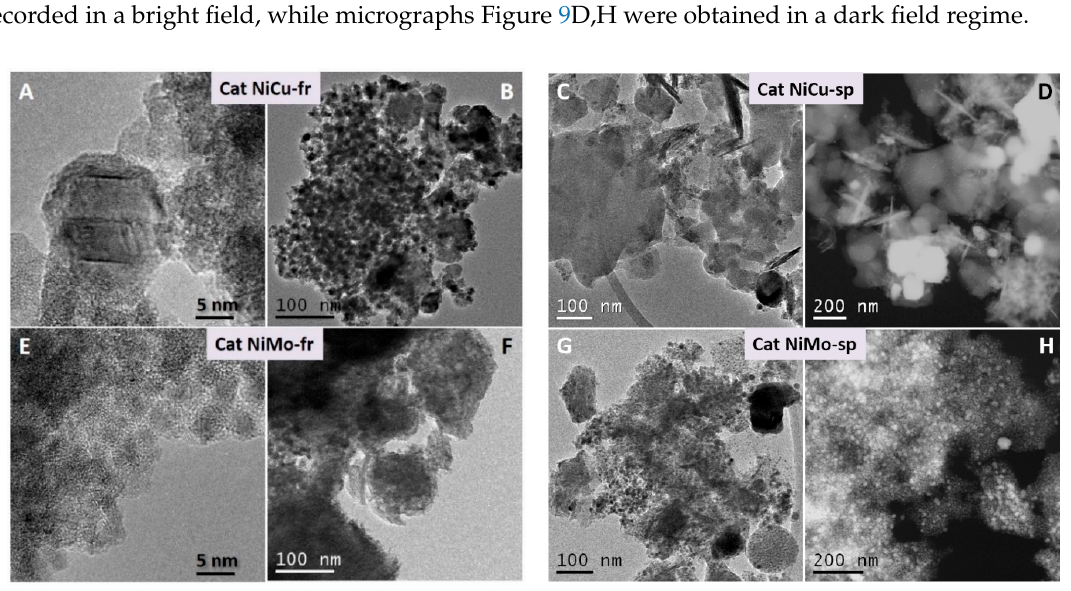
Figure 8. XRD patterns of spent catalysts after hydrotreatment with the three feeds: PL (green line), PO (blue line), PS (red line) at 350 °C, 4 h, 120 bar H 2 at RT.